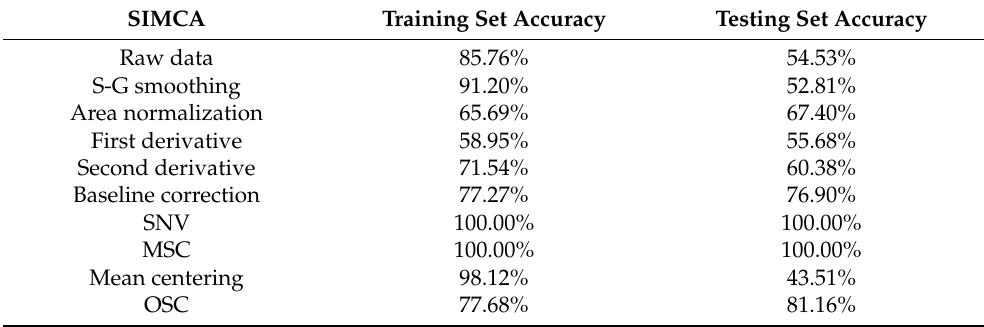
Table 3. Prediction accuracy of the training and testing sets of 9 different pretreatment methods combined with SIMCA respectively. SIMCA Training Set Accuracy Testing Set Accuracy Raw